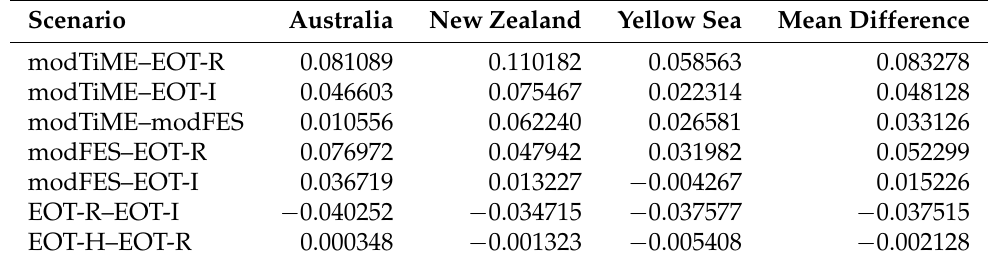
Table 1. The mean sea-level variance difference (in cm 2 ) estimated for each of the listed